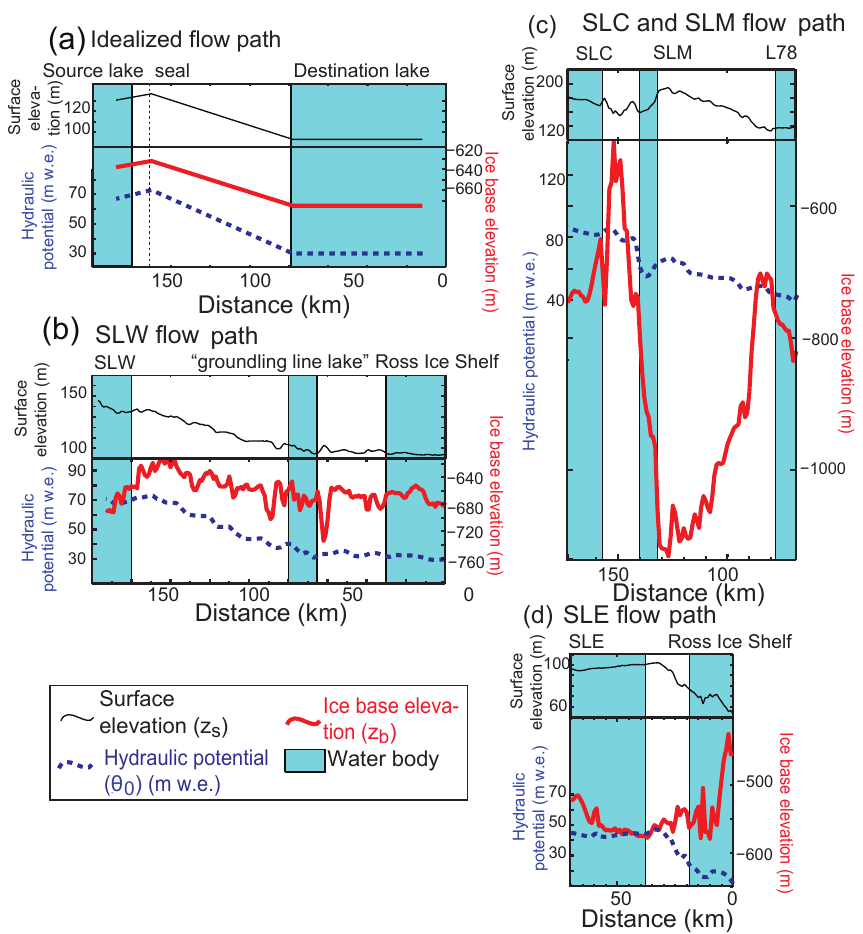
Figure 4. Ice surface elevation, hydropotential, and ice–bed elevation along the following flow paths (see Fig. 1b for location of flow paths): (a) an idealized lake flow path based on SLW, (b) the flow path draining SLW (from Carter and Fricker, 2012), (c) the flow path draining SLC and SLM, and (d) the flow path draining